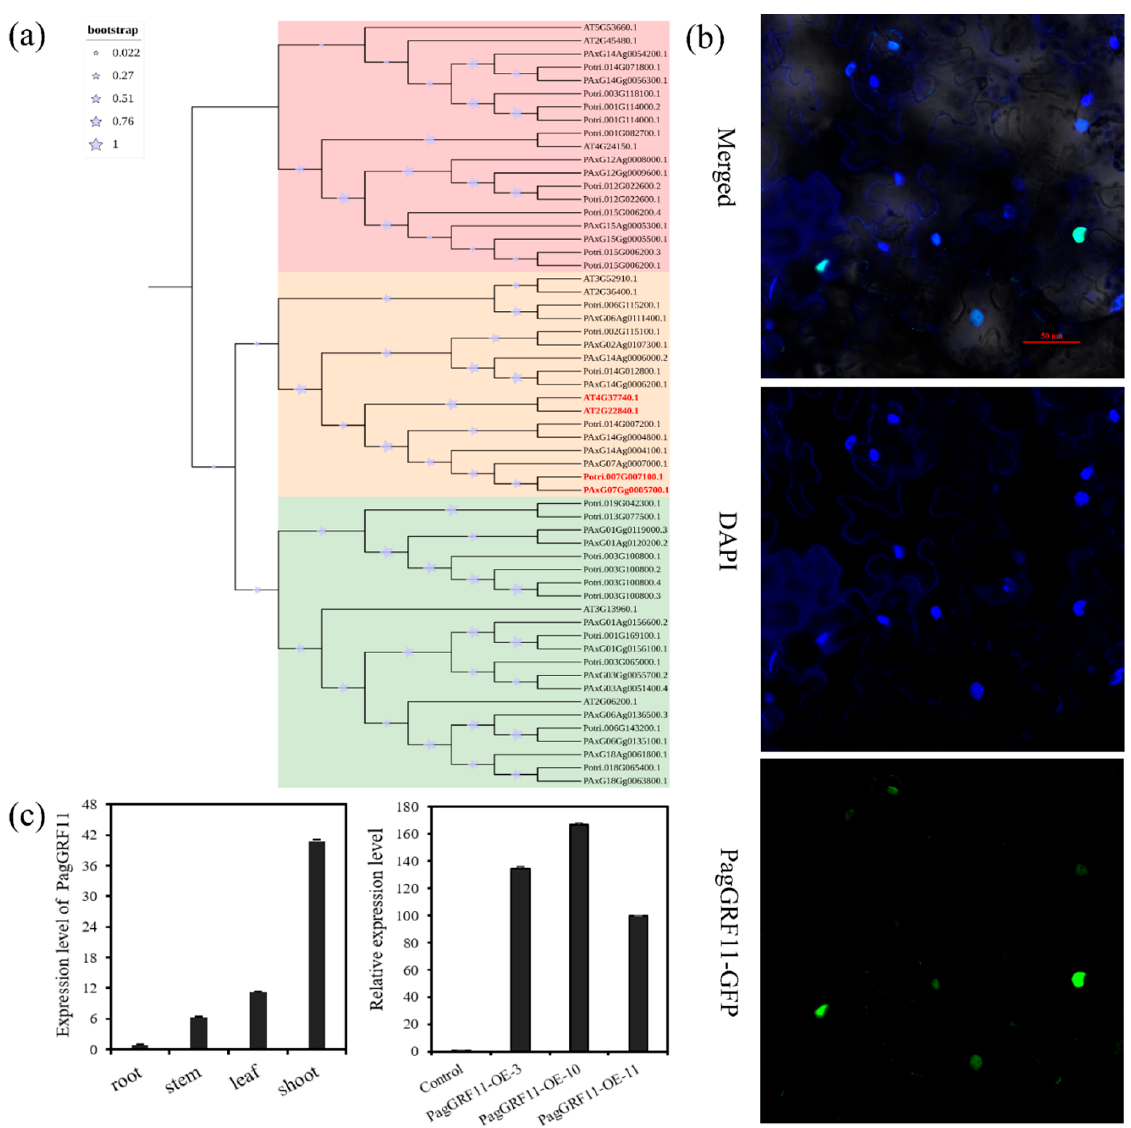
Figure 1. Evolutionary analysis, subcellular localization and expression analysis. ( a ) Neighbor-joining phylogenetic tree of PagGRF-related proteins from “84K”, Arabidopsis thaliana, and Populus . The tree was constructed from an alignment conducted using MEGA X with 1000 bootstrap replicates; the bootstrap value for each node is shown on the tree with star symbol. ( b ) PagGRF11-GFP fusion reporter in N. Subcellular localization of the tobacco cells by confocal laser microscopy. GFP, DAPI and merged images are shown (scale bar = 50 µ m). GFP: Green fluorescent signal of PagGRF11-GFP protein, DAPI: Blue nucleus fluorescence signal. ( c ) Expression patterns of PagGRF11 in different tissues of “84K” poplar (left). The horizontal axis represents different tissues, and the vertical axis represents qRT-PCR value. Expression levels of PagGRF11 in control and transgenic plants (right). The vertical axis represents the values of qRT-PCR and the horizontal axis represents different samples. Control: “84K” populus carried the pBI121 empty vector. PagGRF11-OE-3 , PagGRF11-OE-10 , PagGRF11-OE-11 : Overexpression of PagGRF11 in “84K”